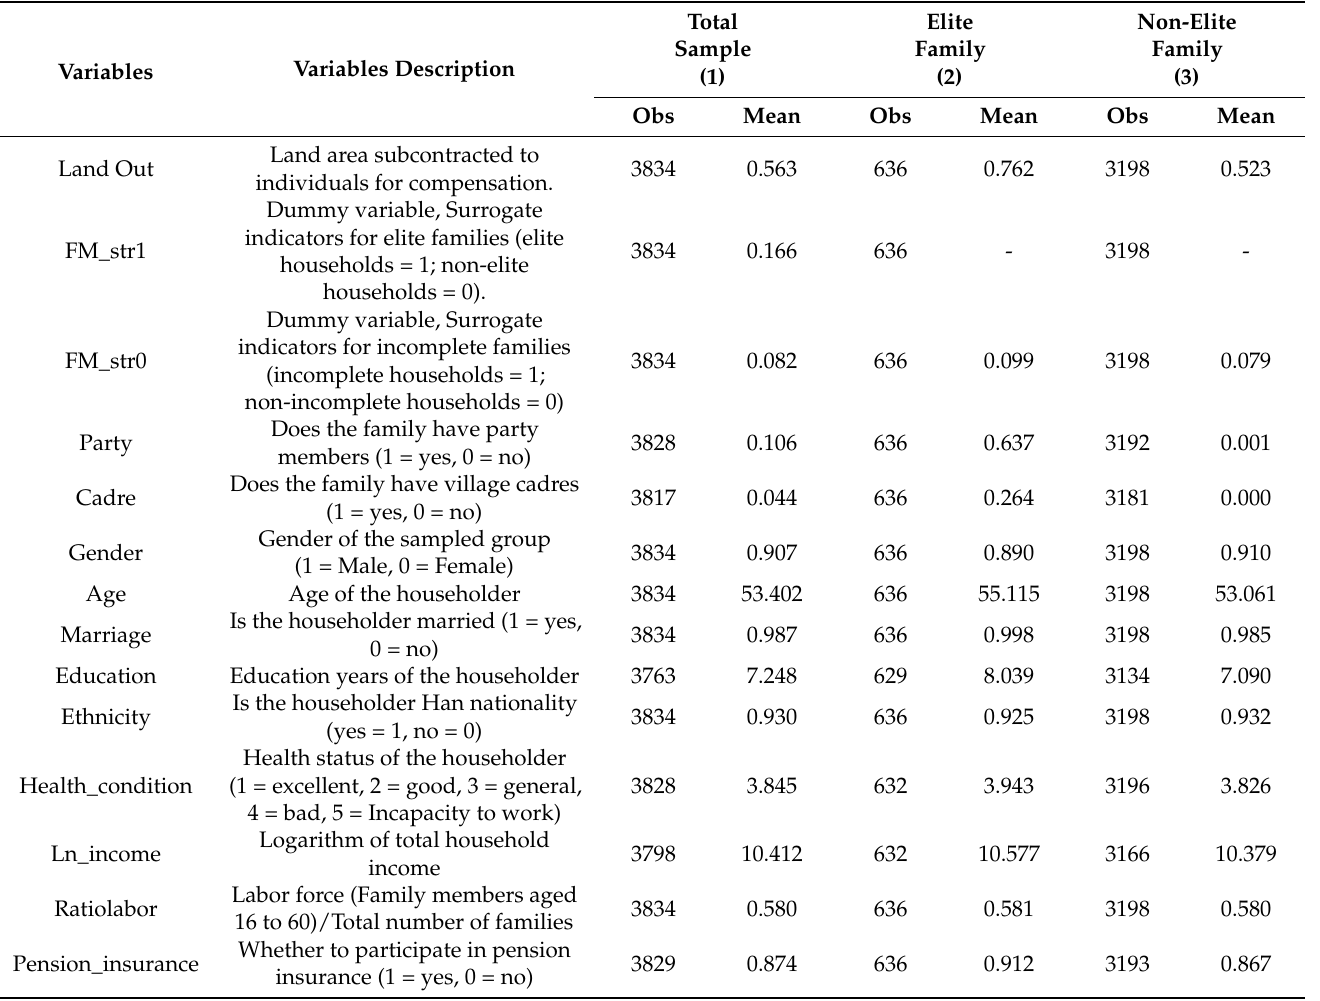
Table 1. Descriptive statistics of